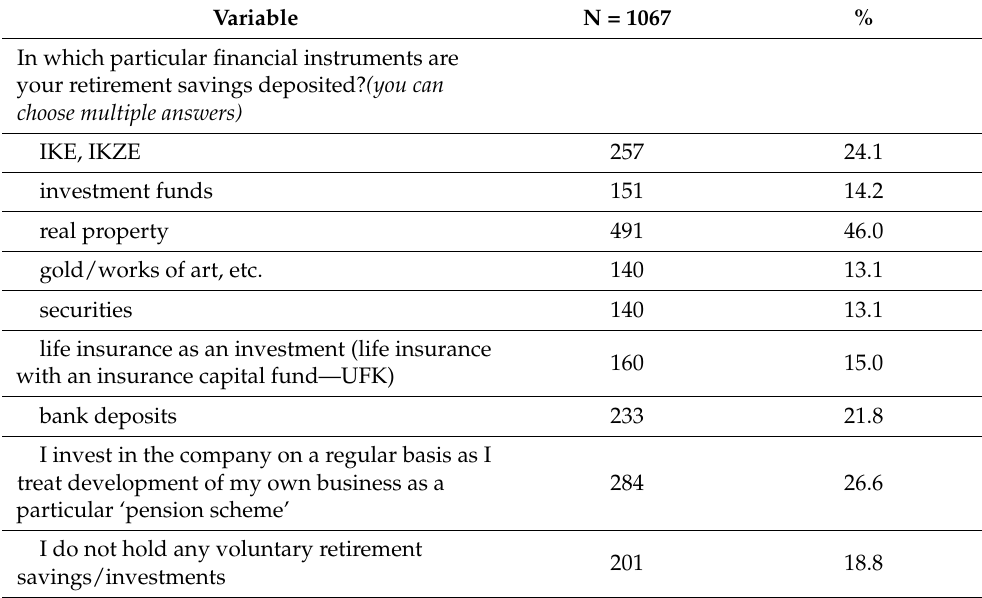
Table 4. Forms of collecting retirement savings by